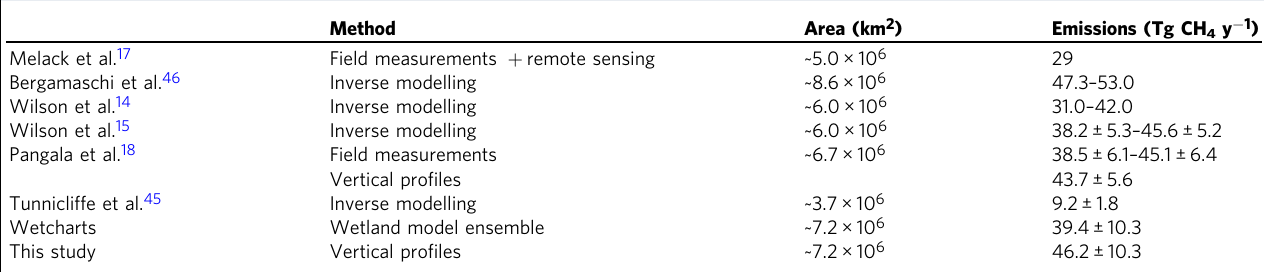
Table 2 Estimates of CH 4 emissions (Tg CH 4 yr − 1 ) and details of previous studies from the Amazon region and estimates from this study.